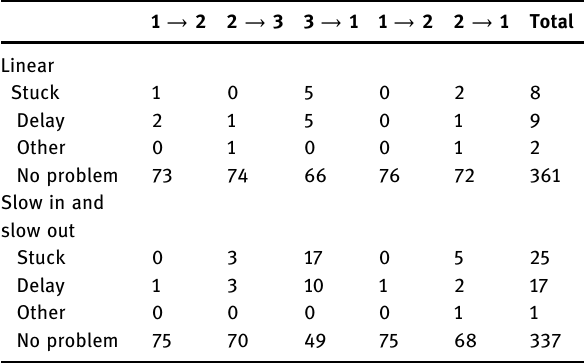
Table 1: Count of occurrences the robot had problems moving from position to position split by velocity curve for linear and slow in and slow out, respectively ( = n 760 ) ; positions are as documented in Figure 2 and the columns follow the procedure documented in Section 4.2